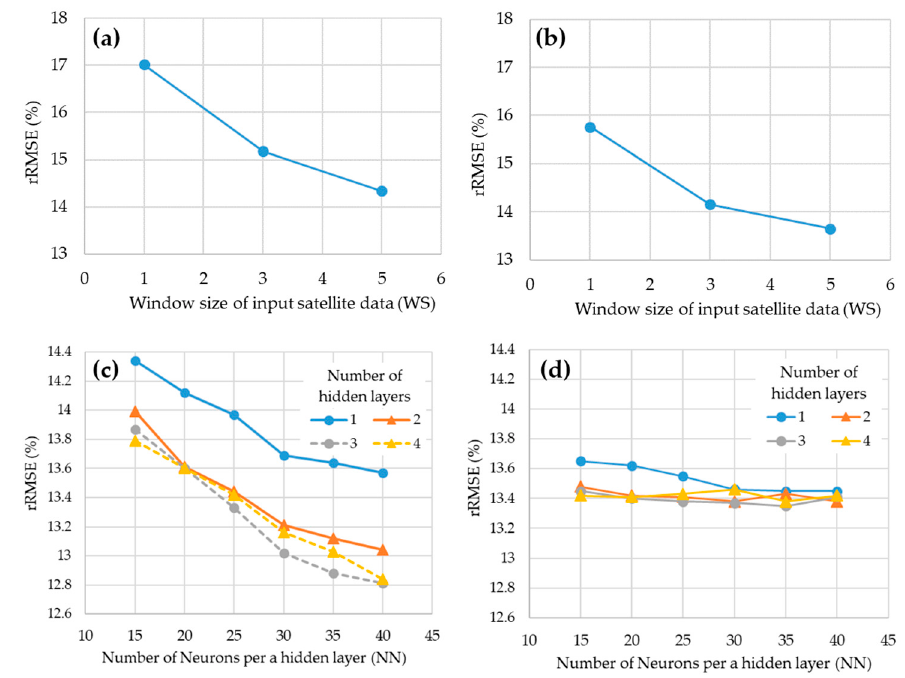
Figure 5. rRMSE of models with various ANN construction parameters; ( a ) rRMSE in the training set according to the width of the satellite image (WS) (NN = 15, NL = 1), ( b ) rRMSE in the test set according to WS (NN = 15, NL = 1), ( c ) rRMSE in the training set according to NL and NN (WS = 5), ( d ) rRMSE in test set according to NL and NN (WS = 5).